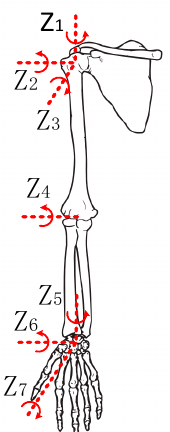
Figure 1. Kinematic model of the upper ‐ limb of the human body.